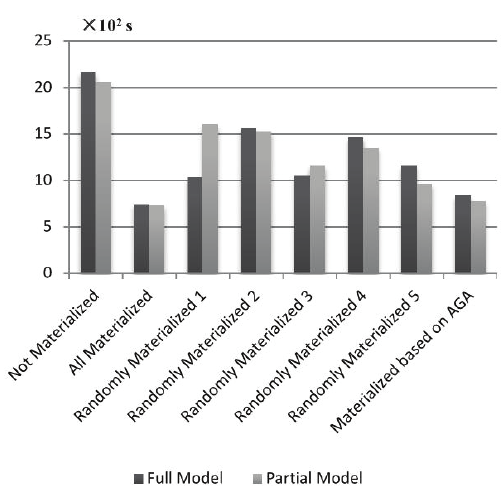
Fig. 6. The time in seconds of 80 queries for different ma- terialized methods with Apache Hive